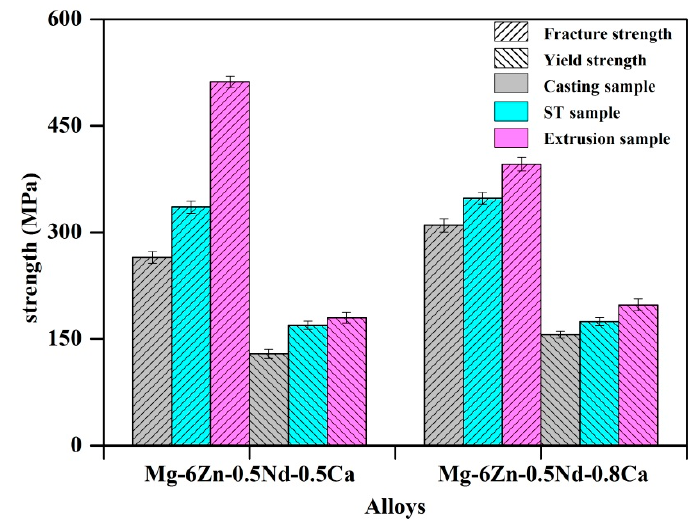
Figure 5. Compression mechanical properties of Mg–Zn–Nd–Ca alloys.